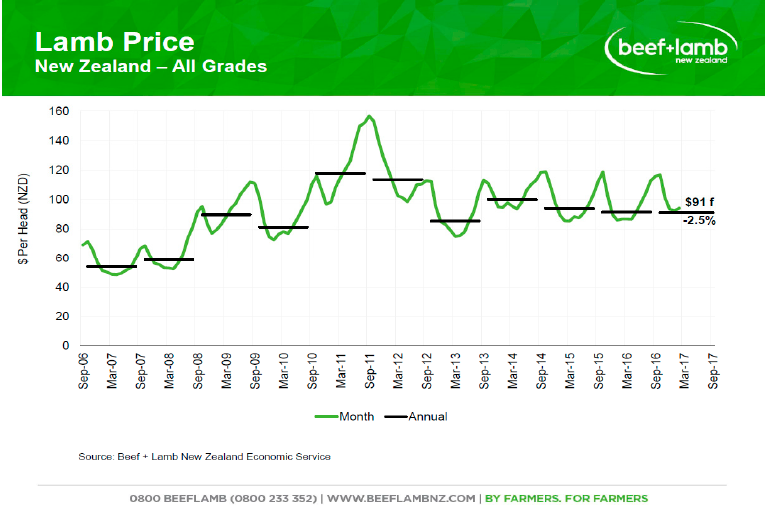
Figure 1. A 10-year movement in lamb prices in New Zealand is shown [3].